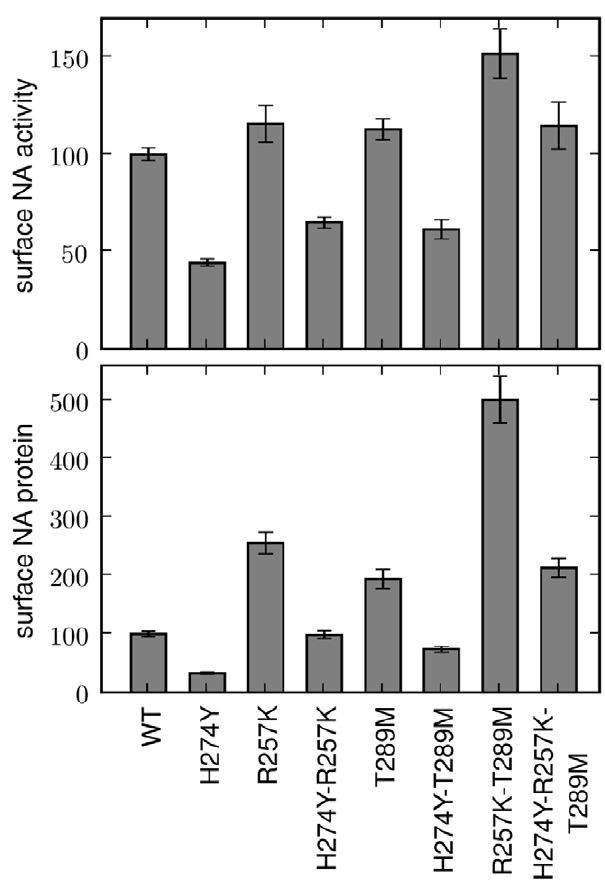
Figure 4. Combining several secondary mutations can fully counteract the effect of H274Y on surface-expressed pandemic H1N1 neuraminidase activity. Shown are wildtype (WT) and indicated mutants of the A/California/4/2009 neuraminidase, all containing C-terminal epitope tags. For the measurements, 293T cells were transfected with plasmids encoding the neuraminidase proteins. After 20 hours, the cells were assayed for the total surface-expressed neuraminidase activity (top panel) or protein using an antibody against the epitope tag (bottom panel). Bars show the mean and standard error for at least six